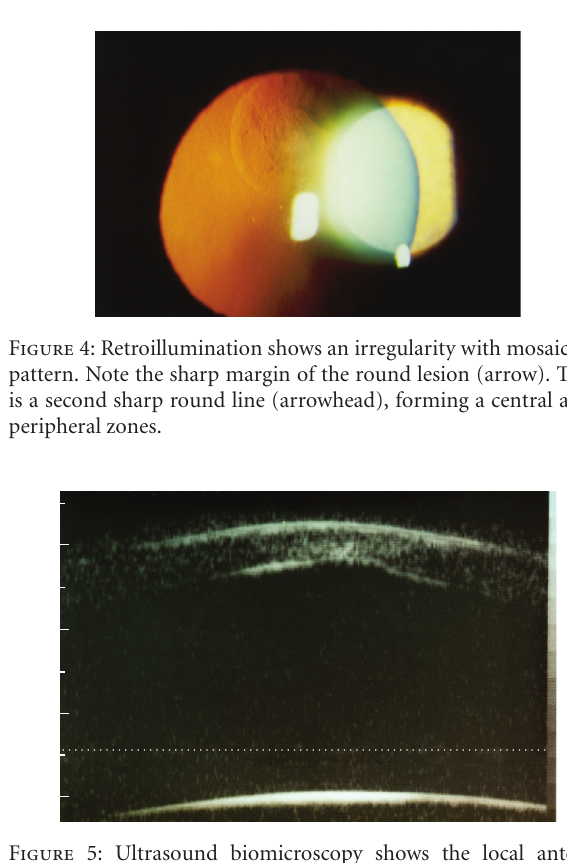
Figure 5: Ultrasound biomicroscopy shows the local anterior bulging of the posterior corneal surface with concomitant thinning of the stroma. Note the configuration of the enhanced stromal reflectivity (arrowhead) corresponding to the stromal